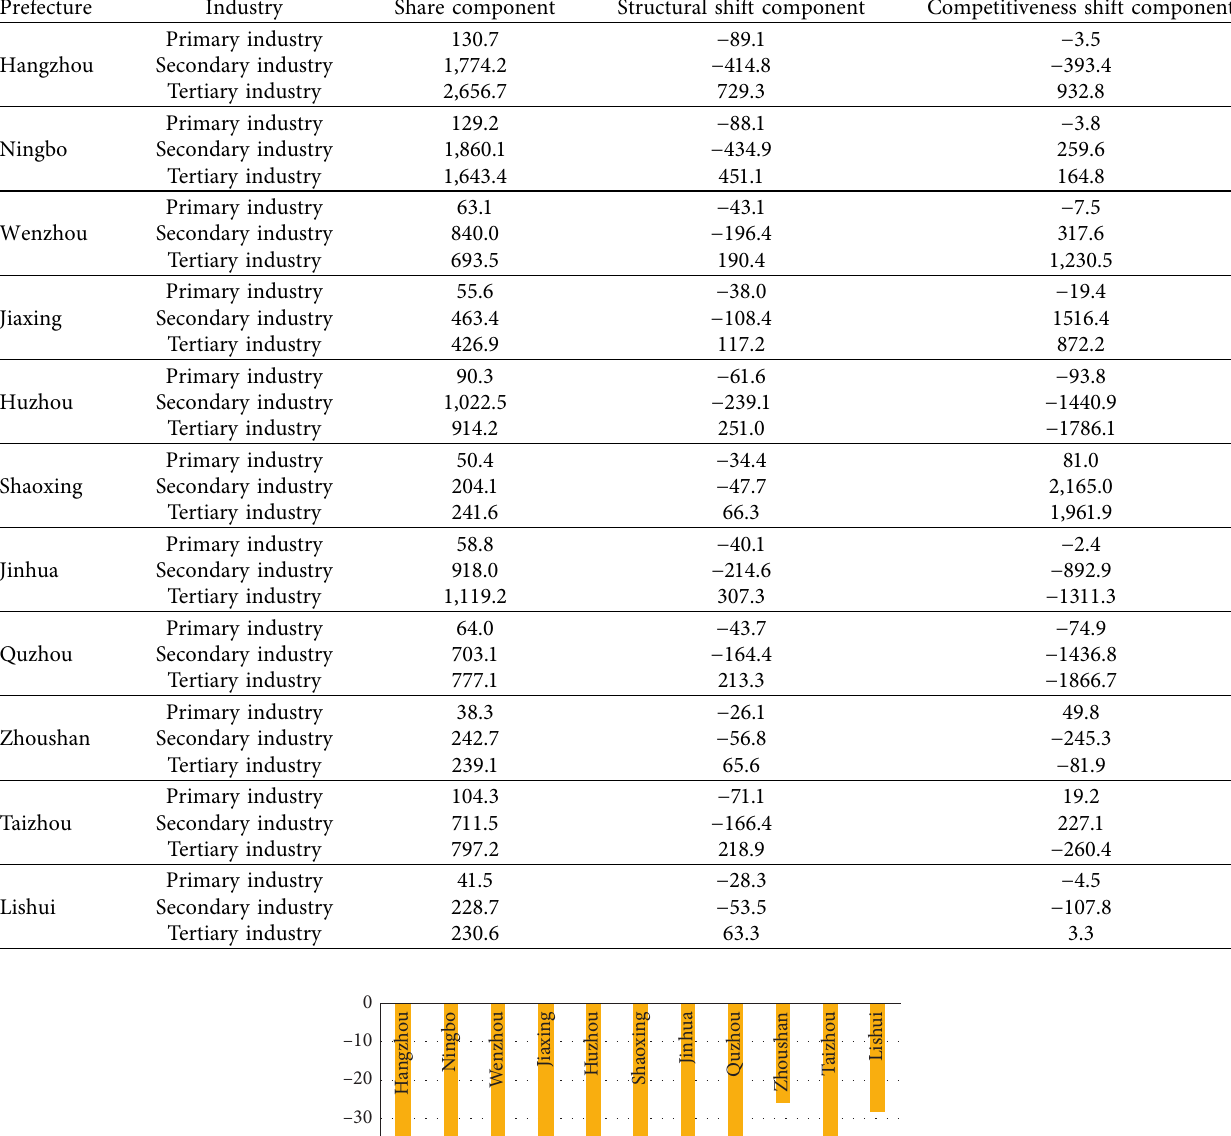
Table 1: SSM results of the 11 prefectures in Zhejiang (unit: 100 million yuan).